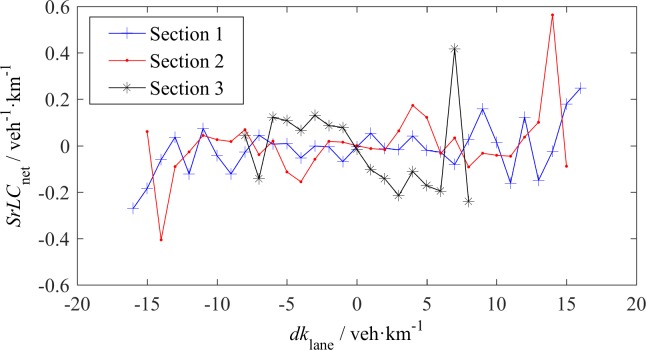
Net inflow LC rate -dklane relationship.